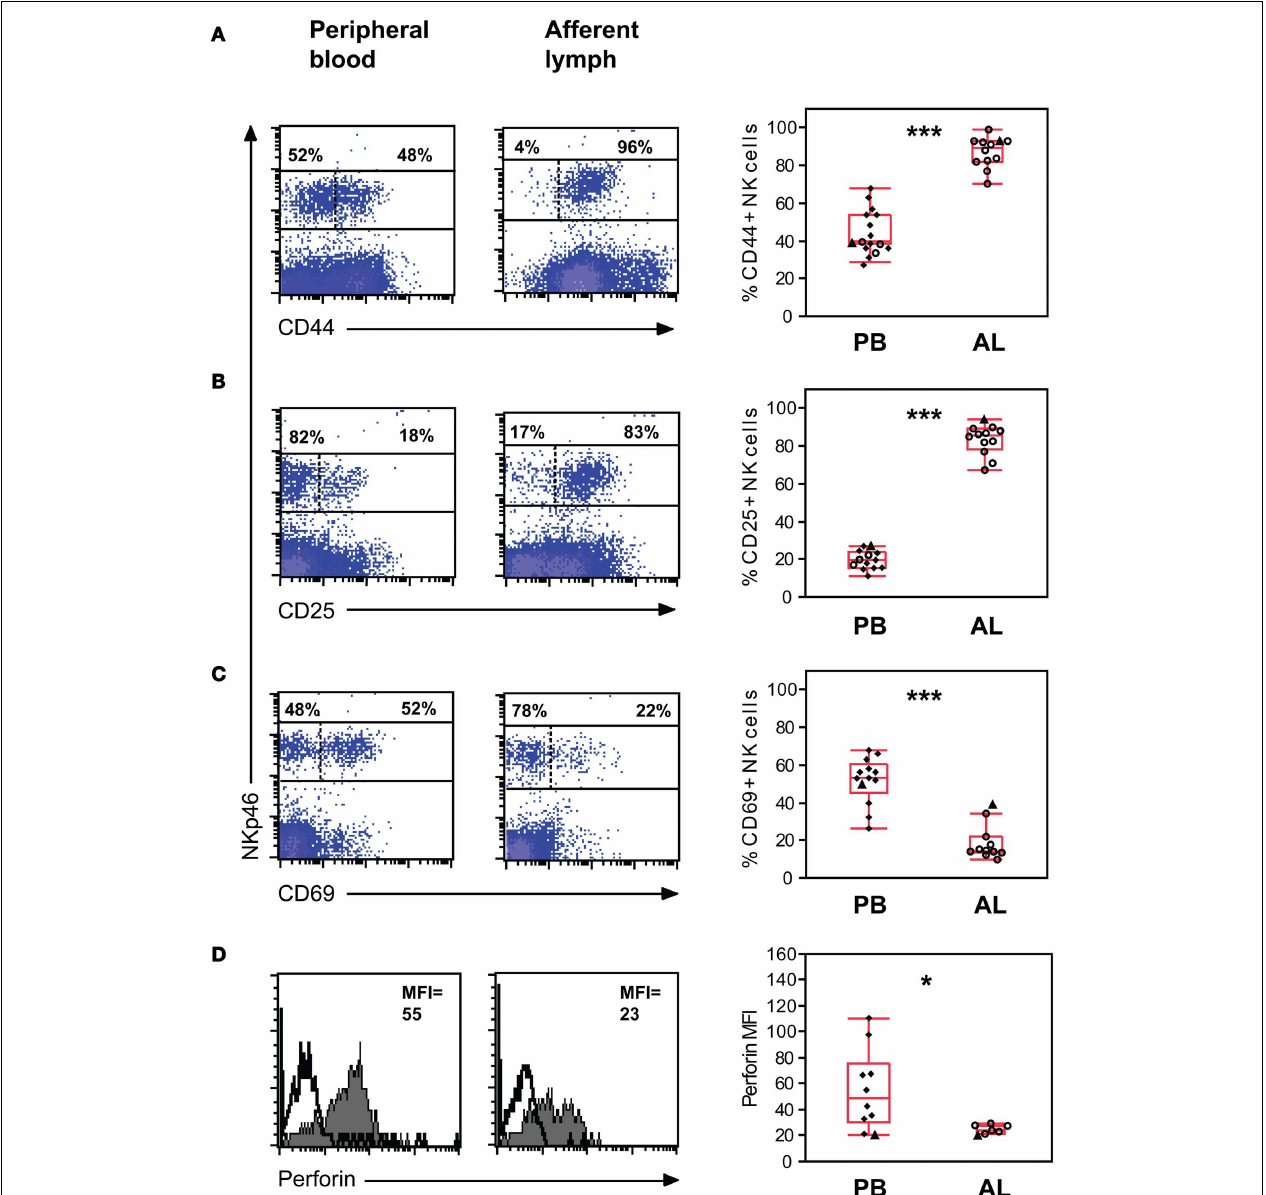
cells in PB ( n = 10–13) and AL ( n = 11–12). (D) Intracellular perforin in NK cells, calculated as mean fluorescence intensity (MFI) of the NK cell population. Histograms displaying representative animals from PB (left panel) and AL (middle panel). Filled histograms indicate perforin expression and solid histograms indicate the secondary control staining. Distribution of the results (right panel) showing MFI of NK cells in PB ( n = 10) and AL ( n = 7). Symbols and statistics as in Figure 1 (* p < 0.05, *** p <